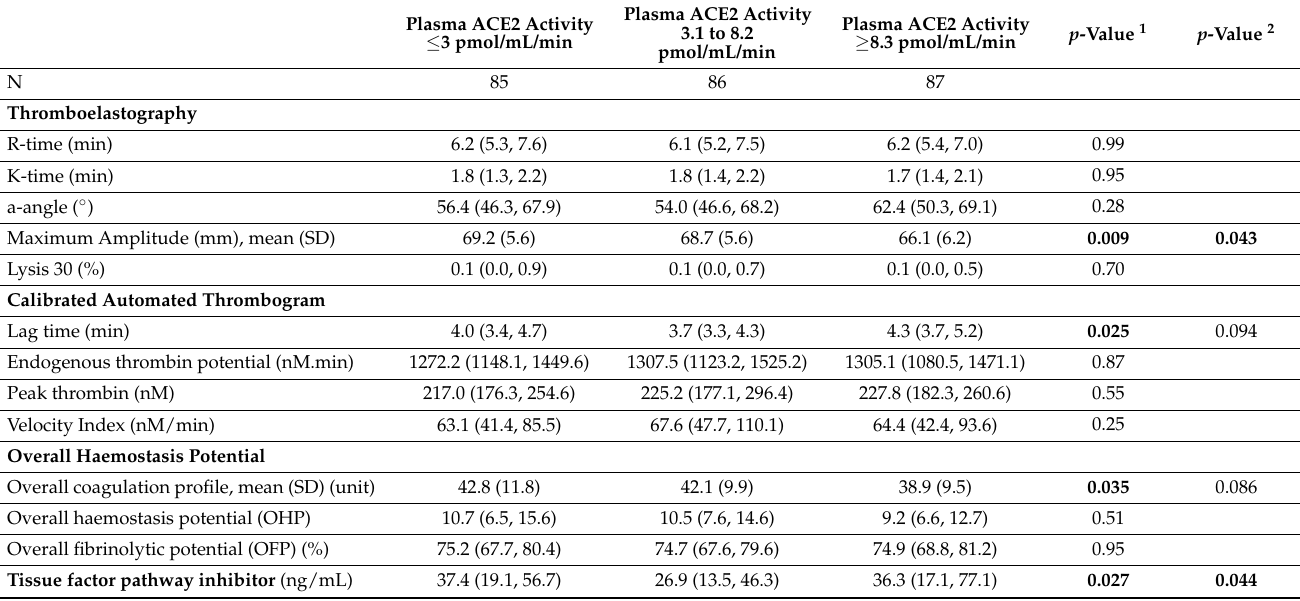
Table 4. Association between global coagulation assays and plasma ACE2 activity levels, reported in tertiles, in patients with cardiovascular risk factors and/or